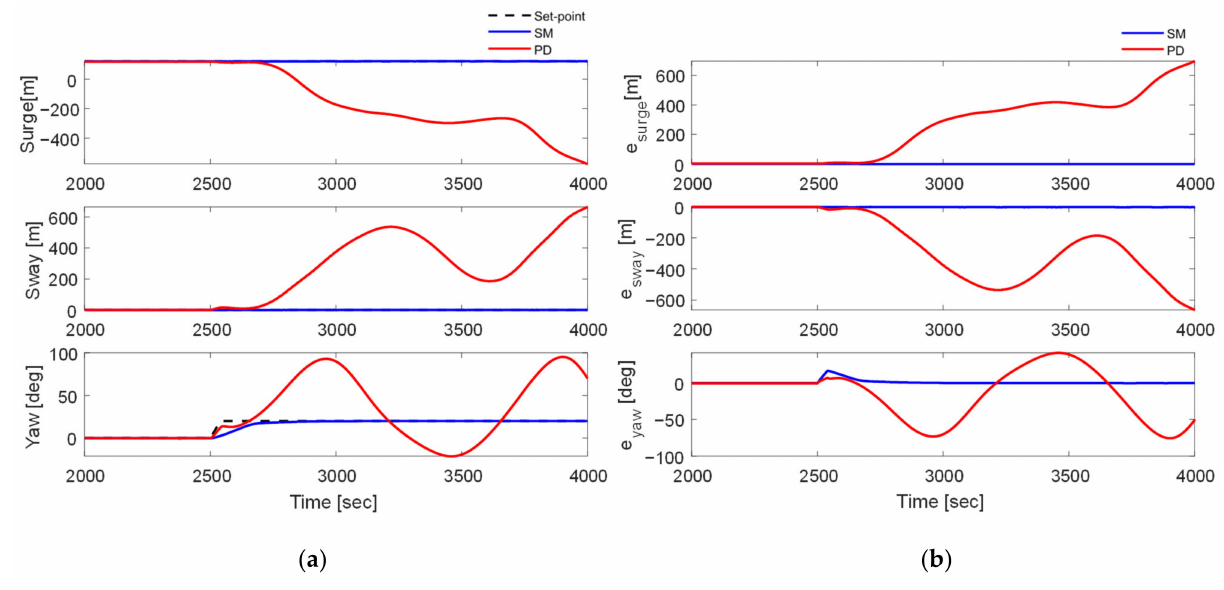
Figure 12. Simulation results of the dynamic motions of FPSO vessel and relative errors with a comparison of the SM and PD controllers according to case 2 according to: ( a ) dynamic motions and ( b ) relative errors.